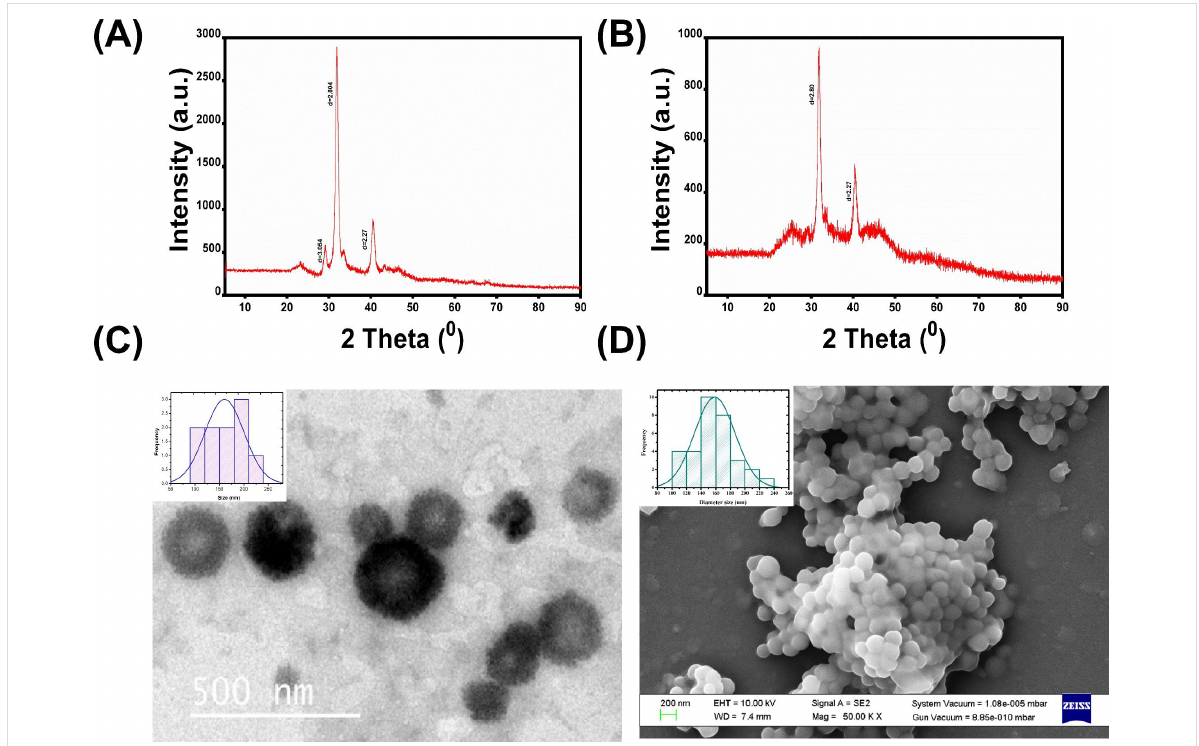
Figure 3: The X-ray diffraction pattern of (A) CaP NPs and (B) CaP@5-FU NPs. (C) TEM and (D) FE-SEM micrographs of CaP@5-FU NPs.